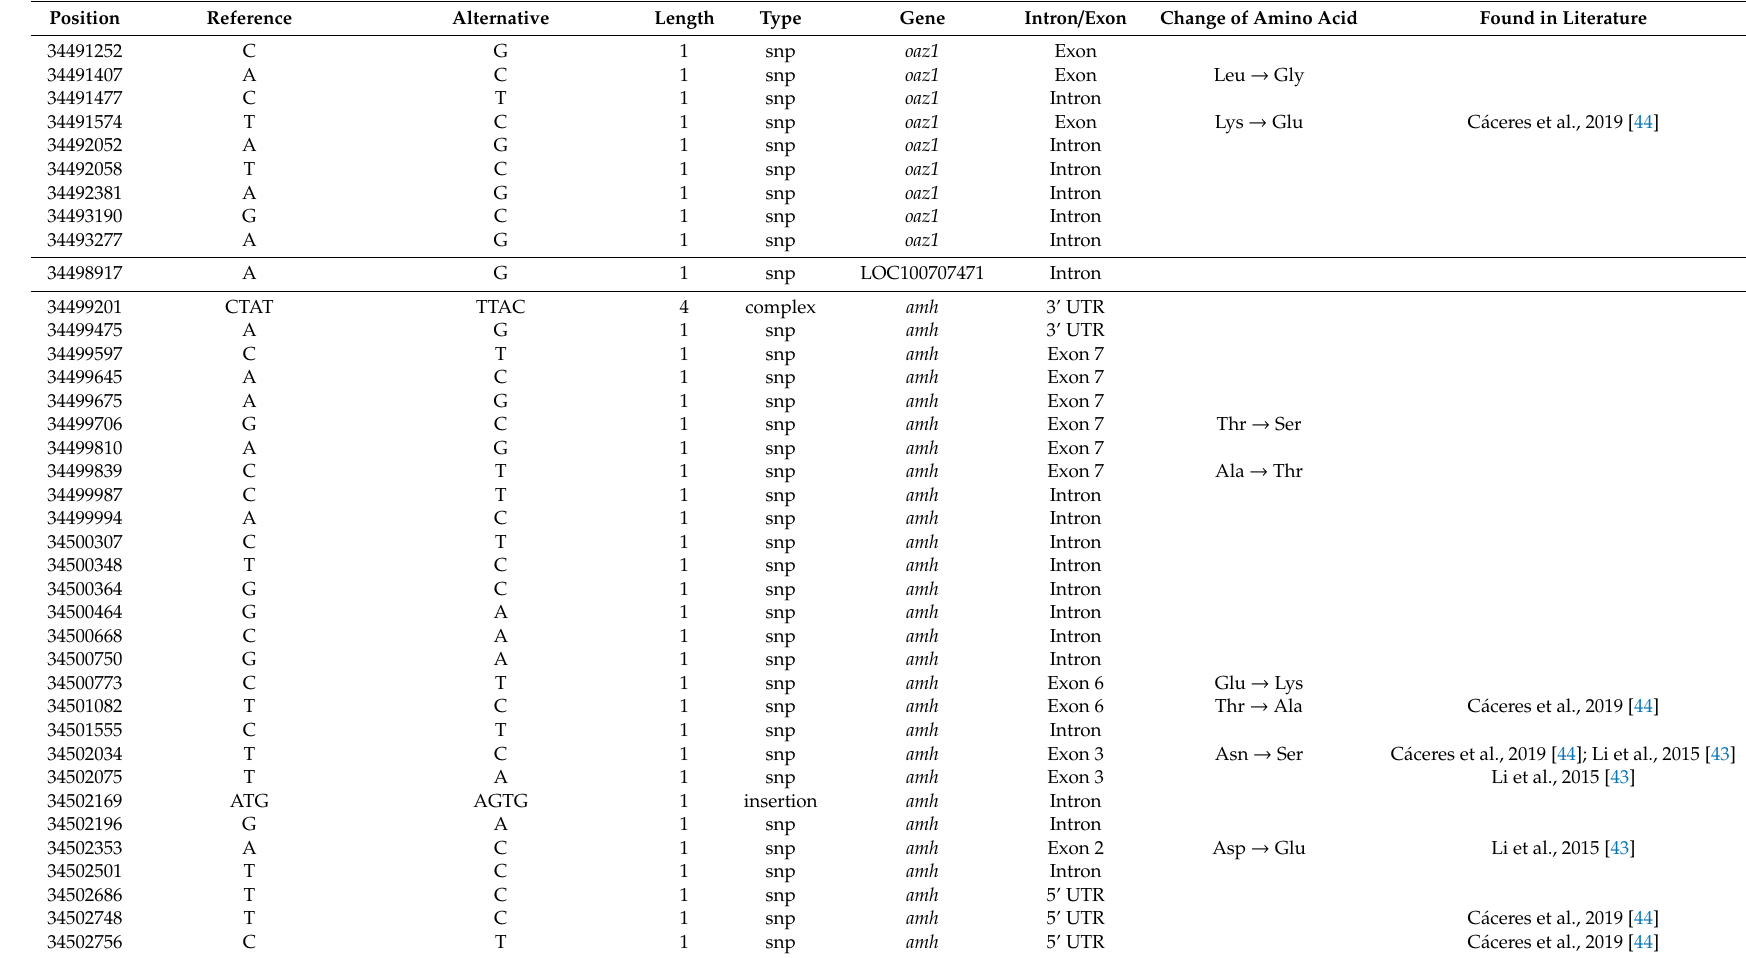
Table 4. SNPs and small indels found in the sex-determining oaz1 - dot1l region on the Y haplotype between males and females of both